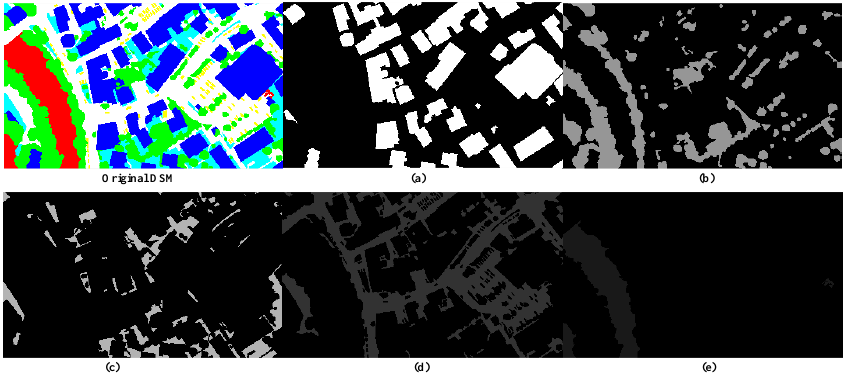
Figure 8. Modeling a DSM as an occlusion of textures. ( a – e ) is one of the five random textures. McCanna [17] proved that a local histogram could be approximated by a convex combination of the value histograms of those regions. As a result, segmentation is handled as an optimization,